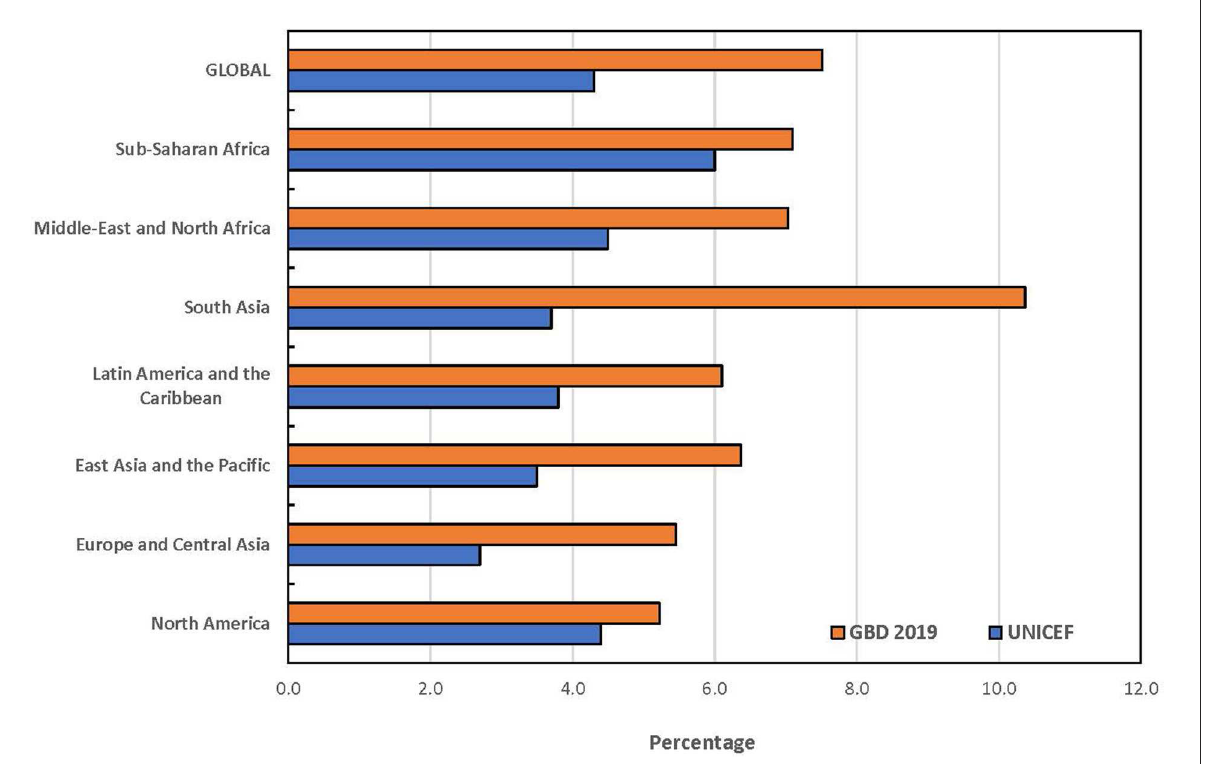
FIGURE1 Prevalence estimates of disabilities among children under 5 years by UNICEF and GBD